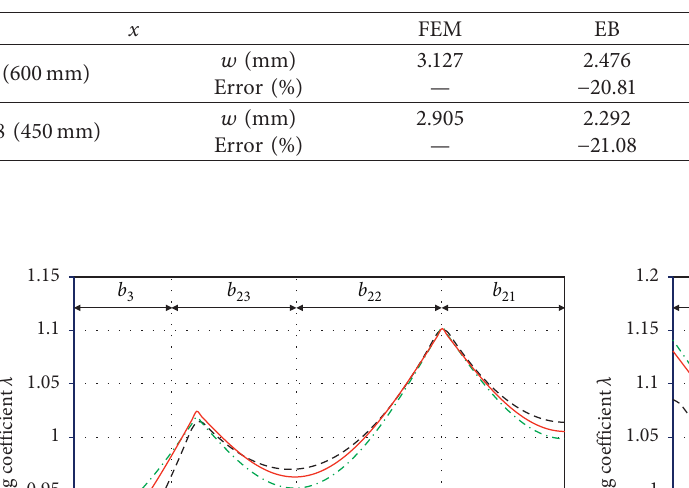
Figure 15: Comparison of vertical deflections predicted by the proposed methods (SL-THY1 and SL-THY2), EBT, TBT, and FEM analysis for the simply supported box girder (example Table 5: Vertical deflections of midspan and 3/8-span of a simply supported box girder (1B3C).